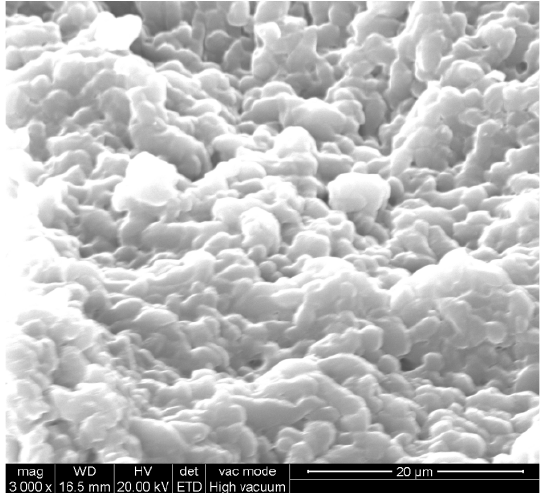
Figure 5. ESEM images of SPEO-Ms at magni fi cation of 3000×.